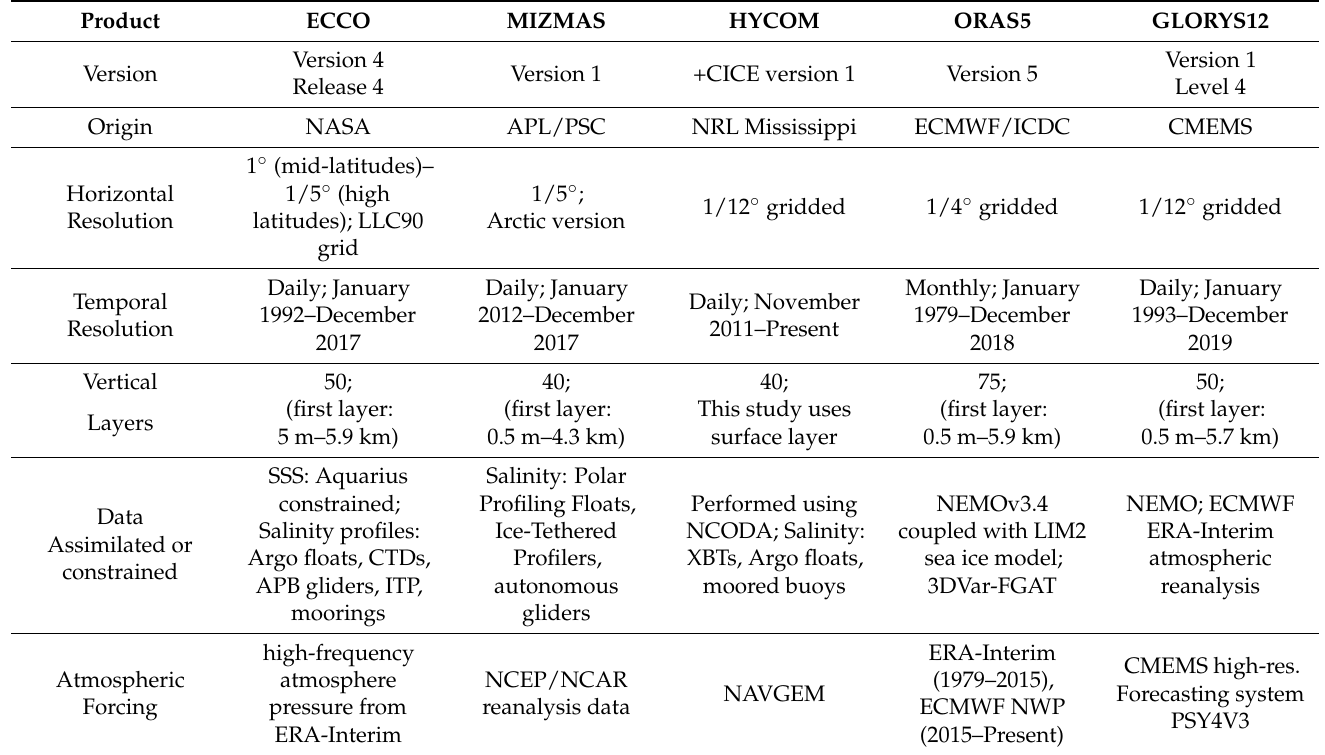
Table 1. Summary of ocean model characteristics used in this